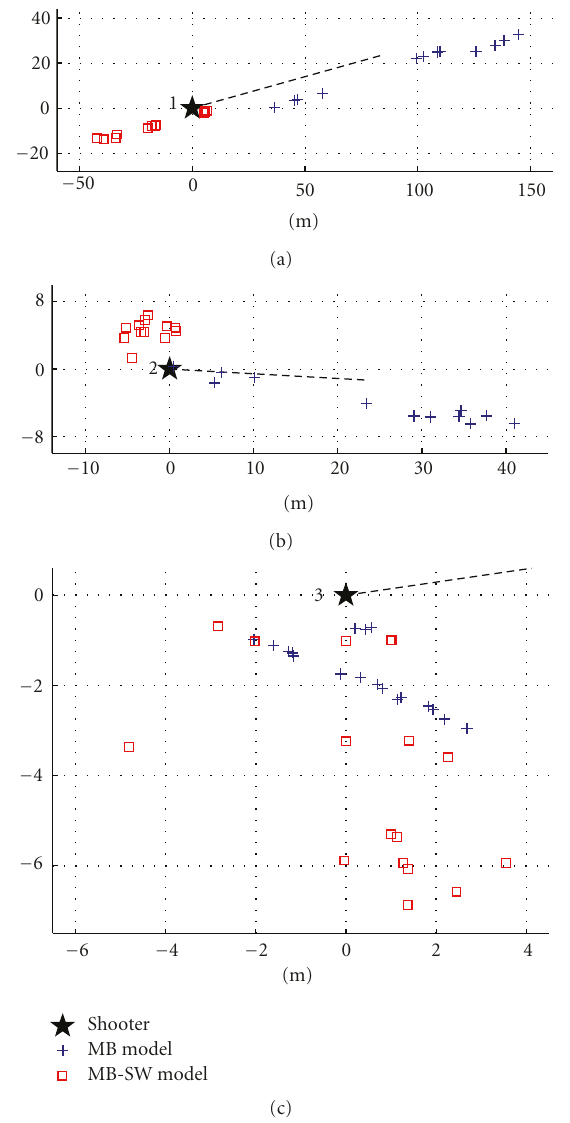
Figure 7: Estimated positions (cid:4) x based on the MB model and on the MB-SW model. The diagrams are enlargements of the interesting areas around the shooter positions. The dashed lines identify the shooting directions.